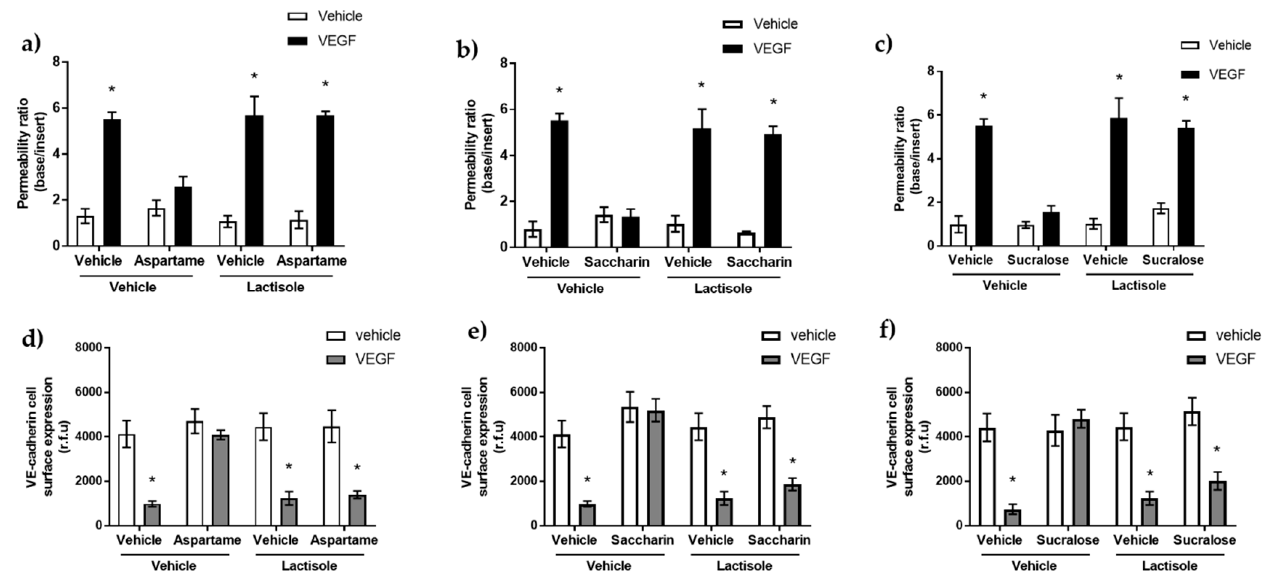
Figure 2. Inhibition of T1R3 using lactisole blocked sweetener-induced protection against VEGF-induced barrier leak across the glomerular microvascular endothelial cell. Panel ( a – c ): Inhibition of sweet taste receptors by lactisole blocks the protective effect of aspartame, saccharin, and sucralose. GMVEC were exposed to 10 µ M aspartame ( a ), 0.1 µ M saccharin ( b ), and 0.1 µ M sucralose ( c ) in the presence and absence of VEGF (50 ng/mL) after pre-treatment with lactisole for 10 min, and permeability was assessed using FITC-D20. Panel ( d – f ): Whole cell indirect ELISA was used to determine GMVEC cell-surface expression of VE-cadherin following exposure to aspartame ( d ), saccharin ( e ), sucralose (panel f), and vehicle (media) in the presence and absence of VEGF and 3 µM of sweet taste inhibitor, lactisole. n = 6. Data are expressed as mean with S.E.M * p < 0.05 vs. vehicle.